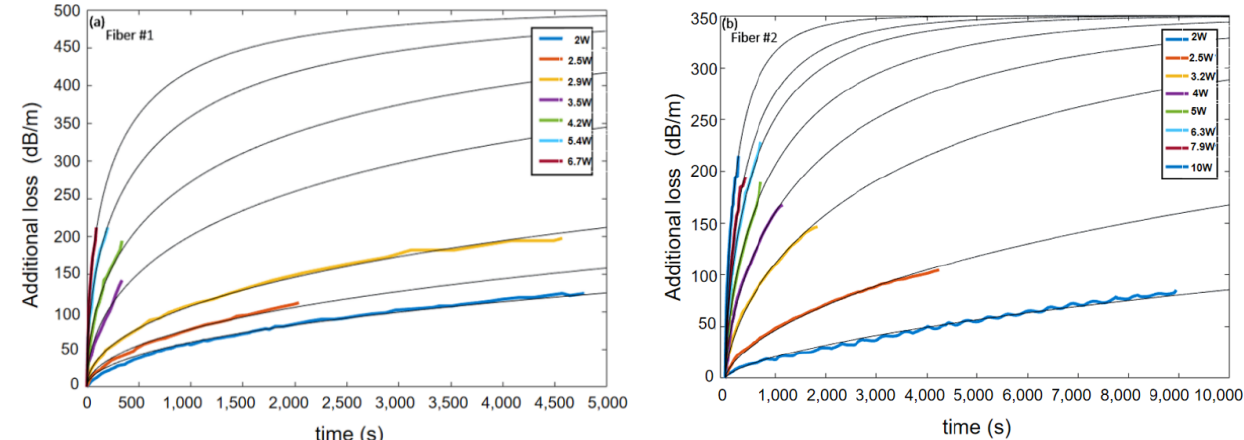
Figure 3. ( a ) Measurement and fitting results of Fiber #1. ( b ) Measurement and fitting results of Fiber #2.